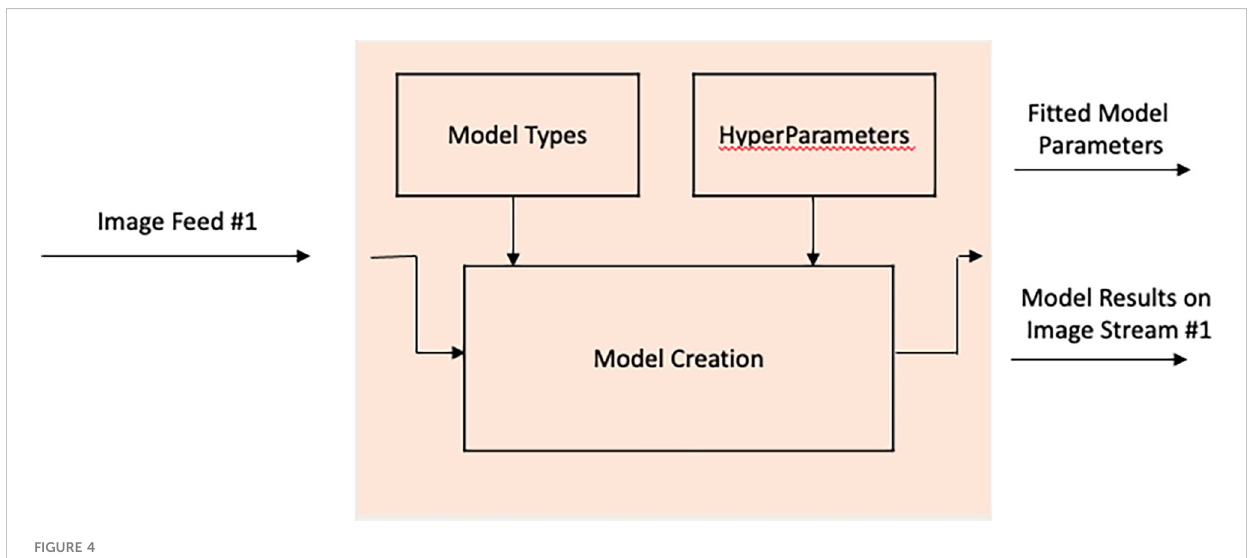
FIGURE 4 Object-of-Interest Detection